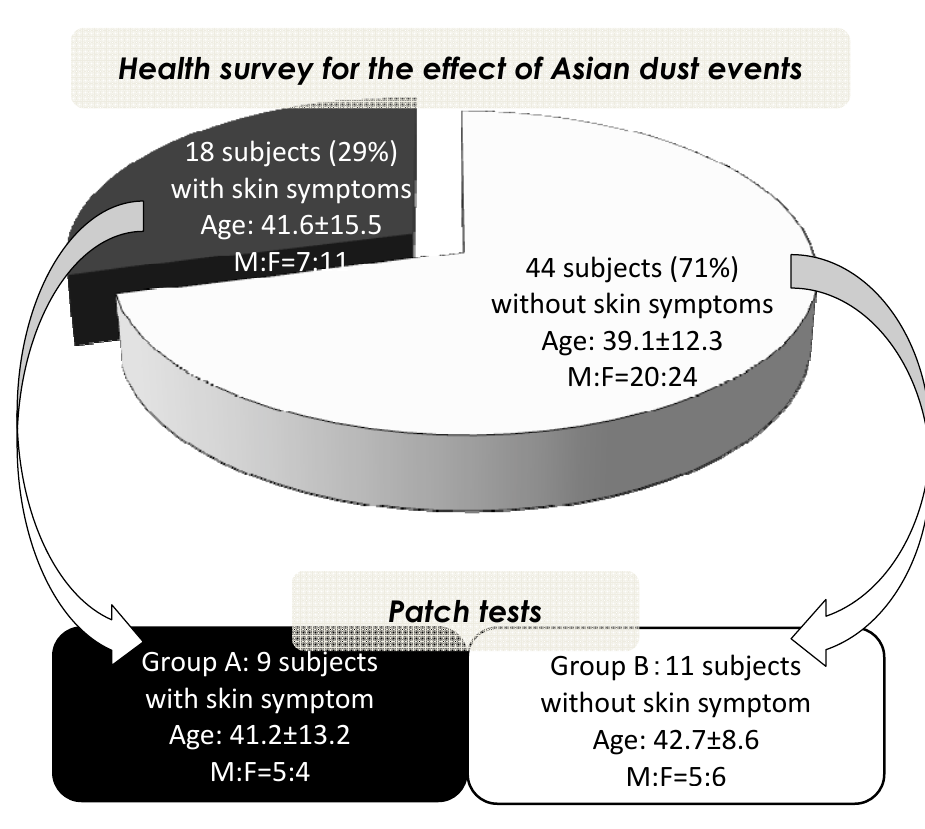
Figure 1. Scheme of case-control